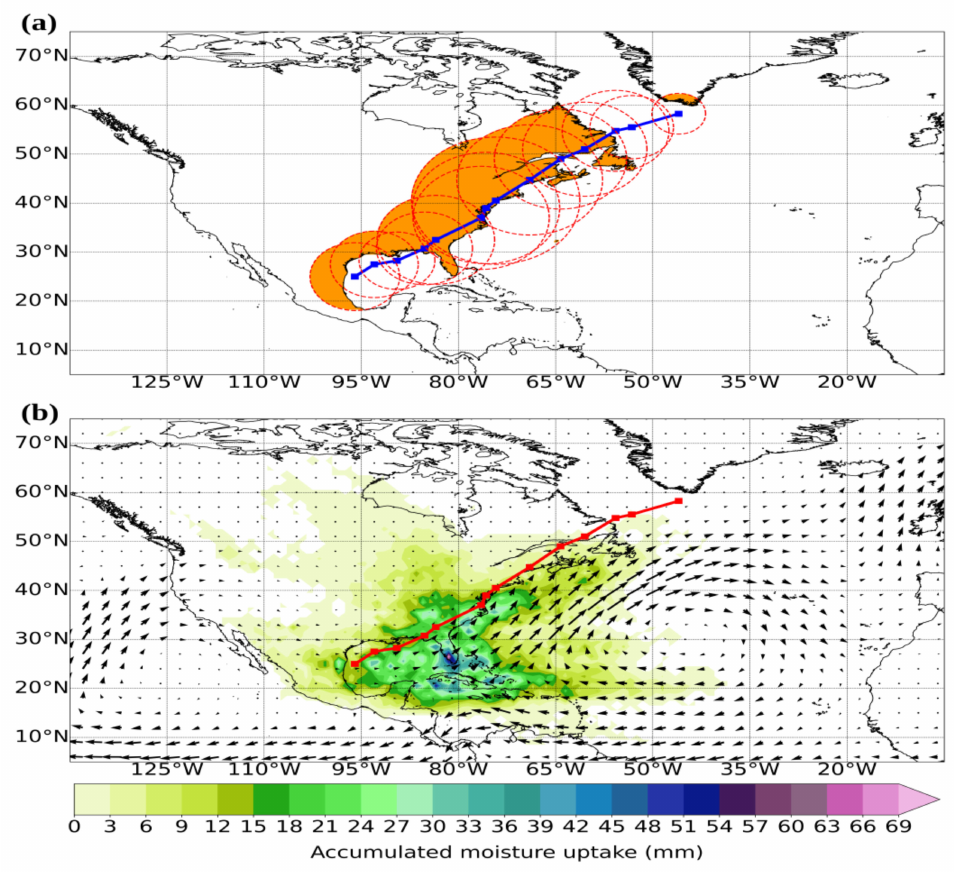
Figure 7. ( a ) Composite of target regions (shaded) to identify the air parcels within the SC93 area that precipitated over land. ( b ) Accumulated moisture uptake (mm) during the SC93 lifetime for the precipitation over land. The vertically integrated moisture flux is represented by arrows (kg/ms). The blue and red lines denote the SC93 trajectory, while the centre of SC93 every 6-h is marked with a filled square. The red-dashed circles in ( a ) denote the SC93